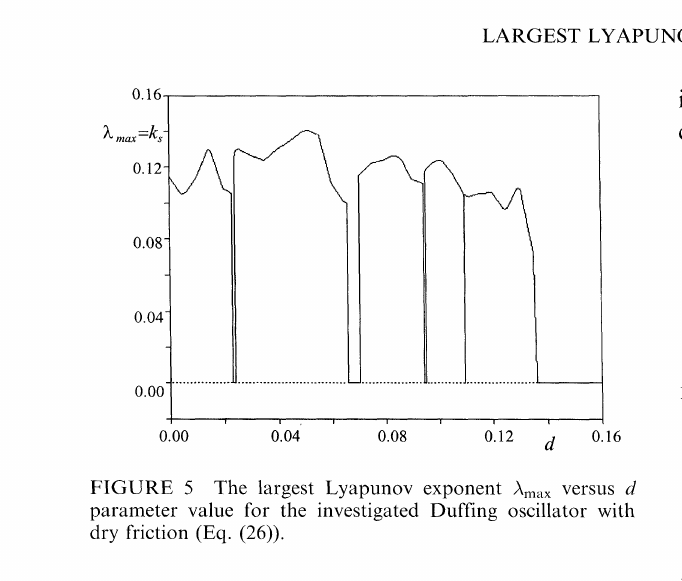
FIGURE 5 The largest Lyapunov exponent XmLx versus d parameter value for the investigated Duffing oscillator with dry friction (Eq. (26)).